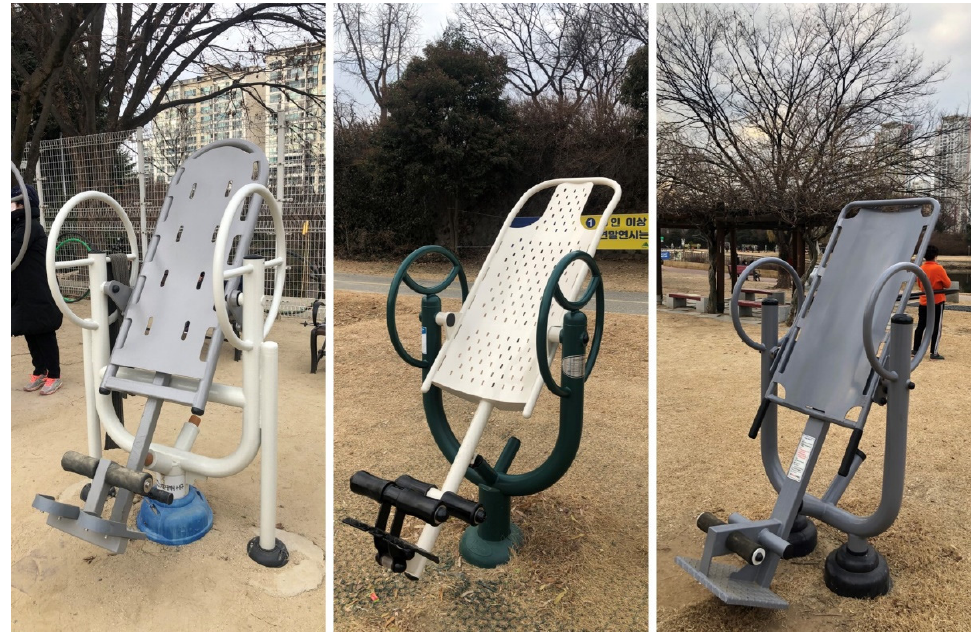
Figure 1. Inversion devices equipped in public exercise places in South Korea.